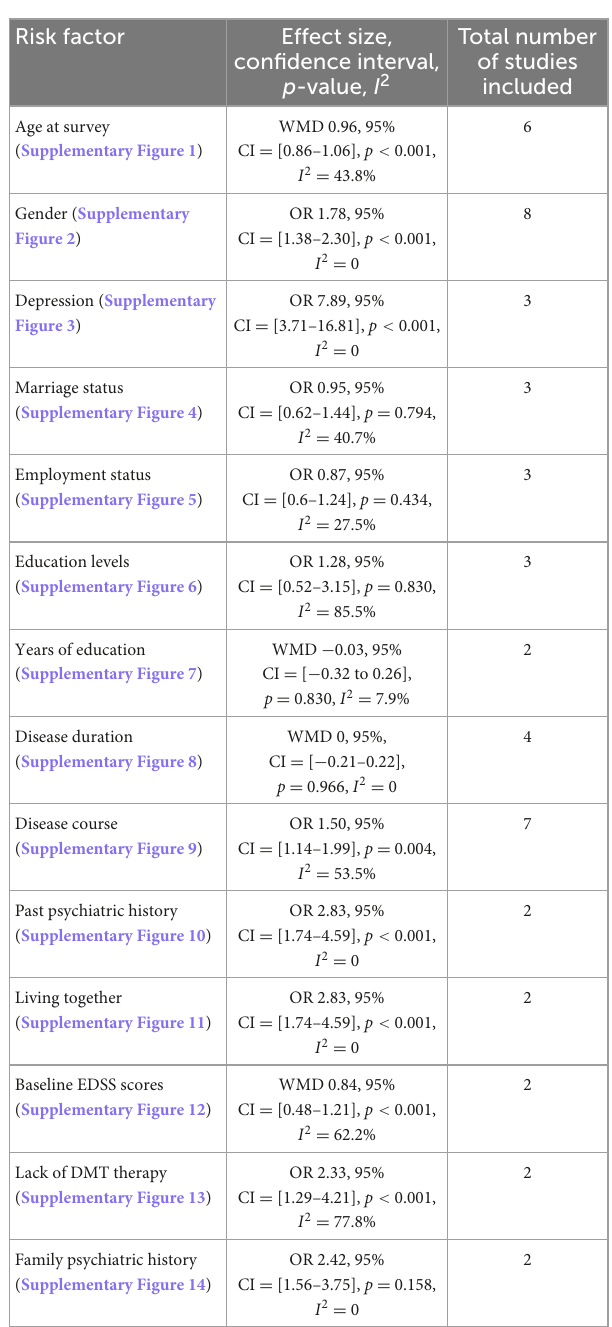
TABLE 3 Factors correlated with anxiety status in MS patients. TABLE 4 Comparisons on risk factors for anxiety in patients with